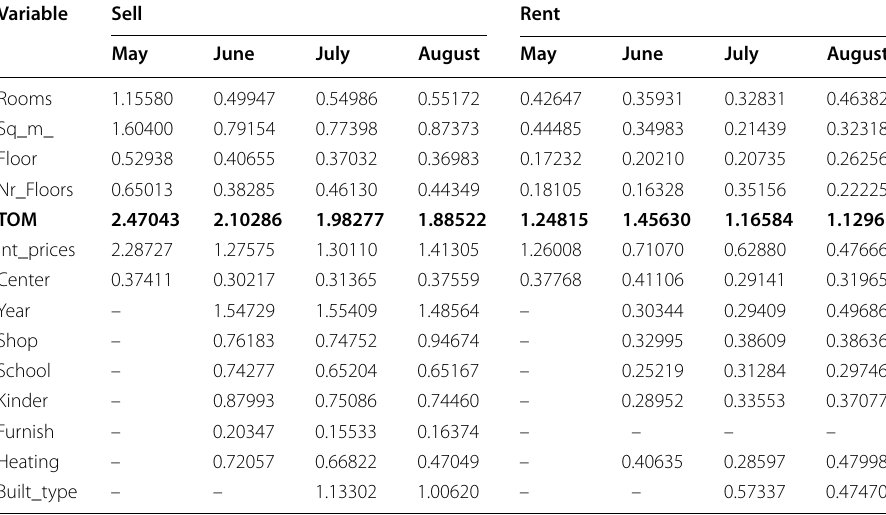
Bold values indicate the most dominant variable in predicting price